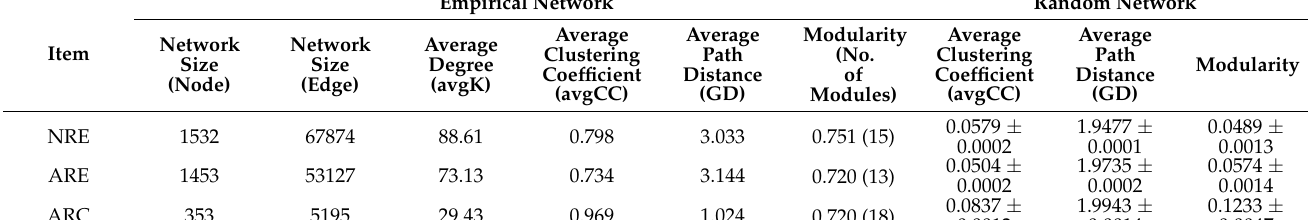
Table 1. Comparison of the roles of the natural water sources (NRE) network, artificially recharged water from earthen pond substrate (ARE) network, and artificially recharged water from concrete pond substrate (ARC) network.